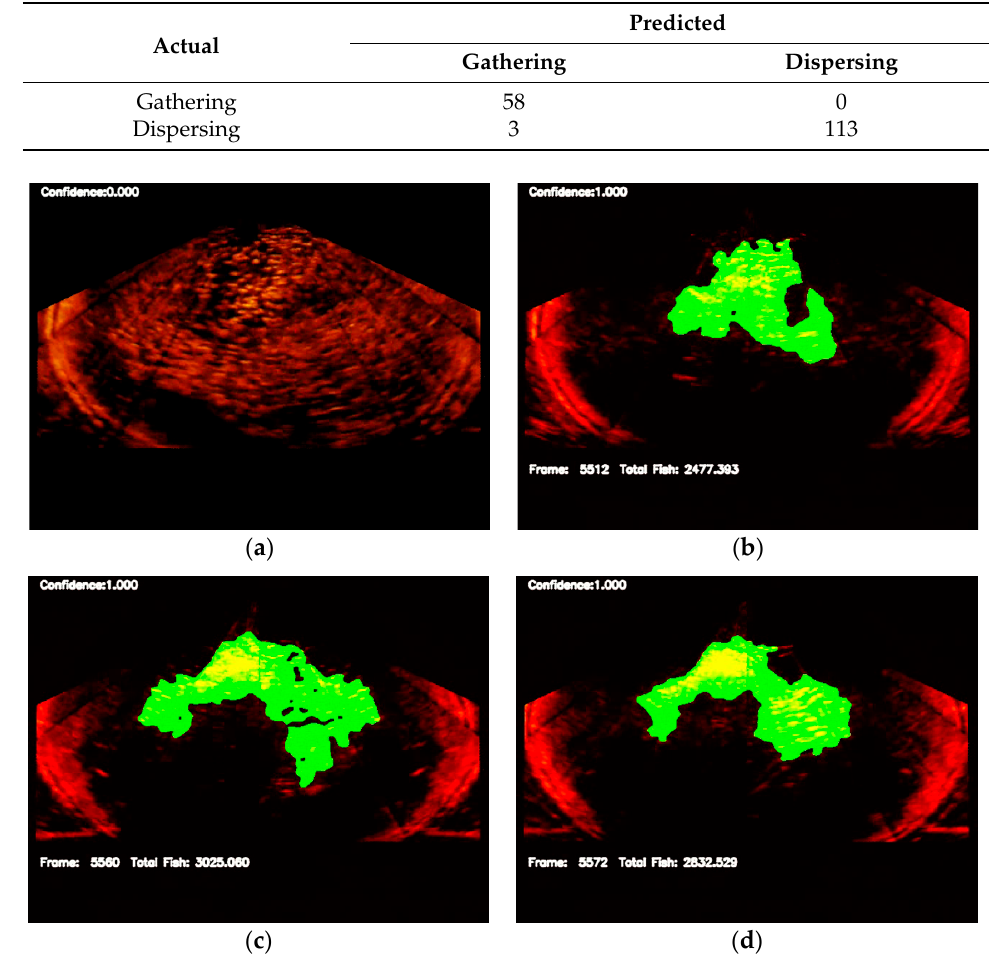
Table 3. The confusion matrix for the CNNs’ detection of fish gathering frame.